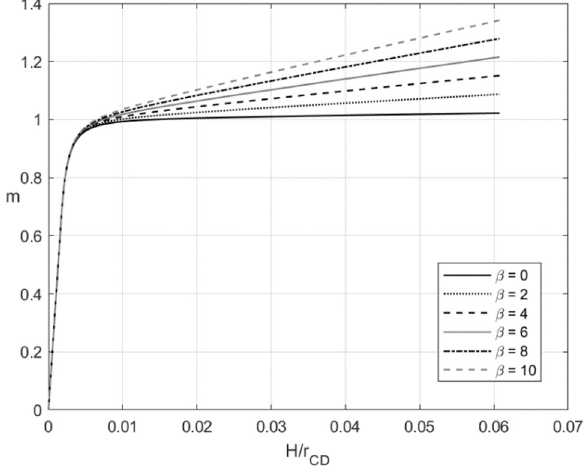
= H r = H r at 0 f and several at 0 f and several